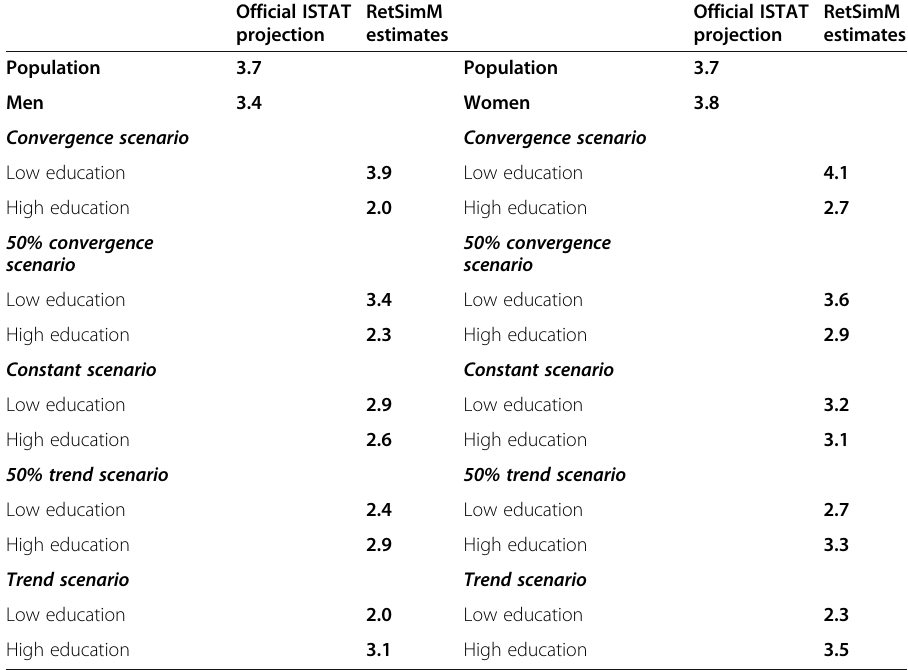
50% Constant 50% Trend conv. scenario trend scenario scenario